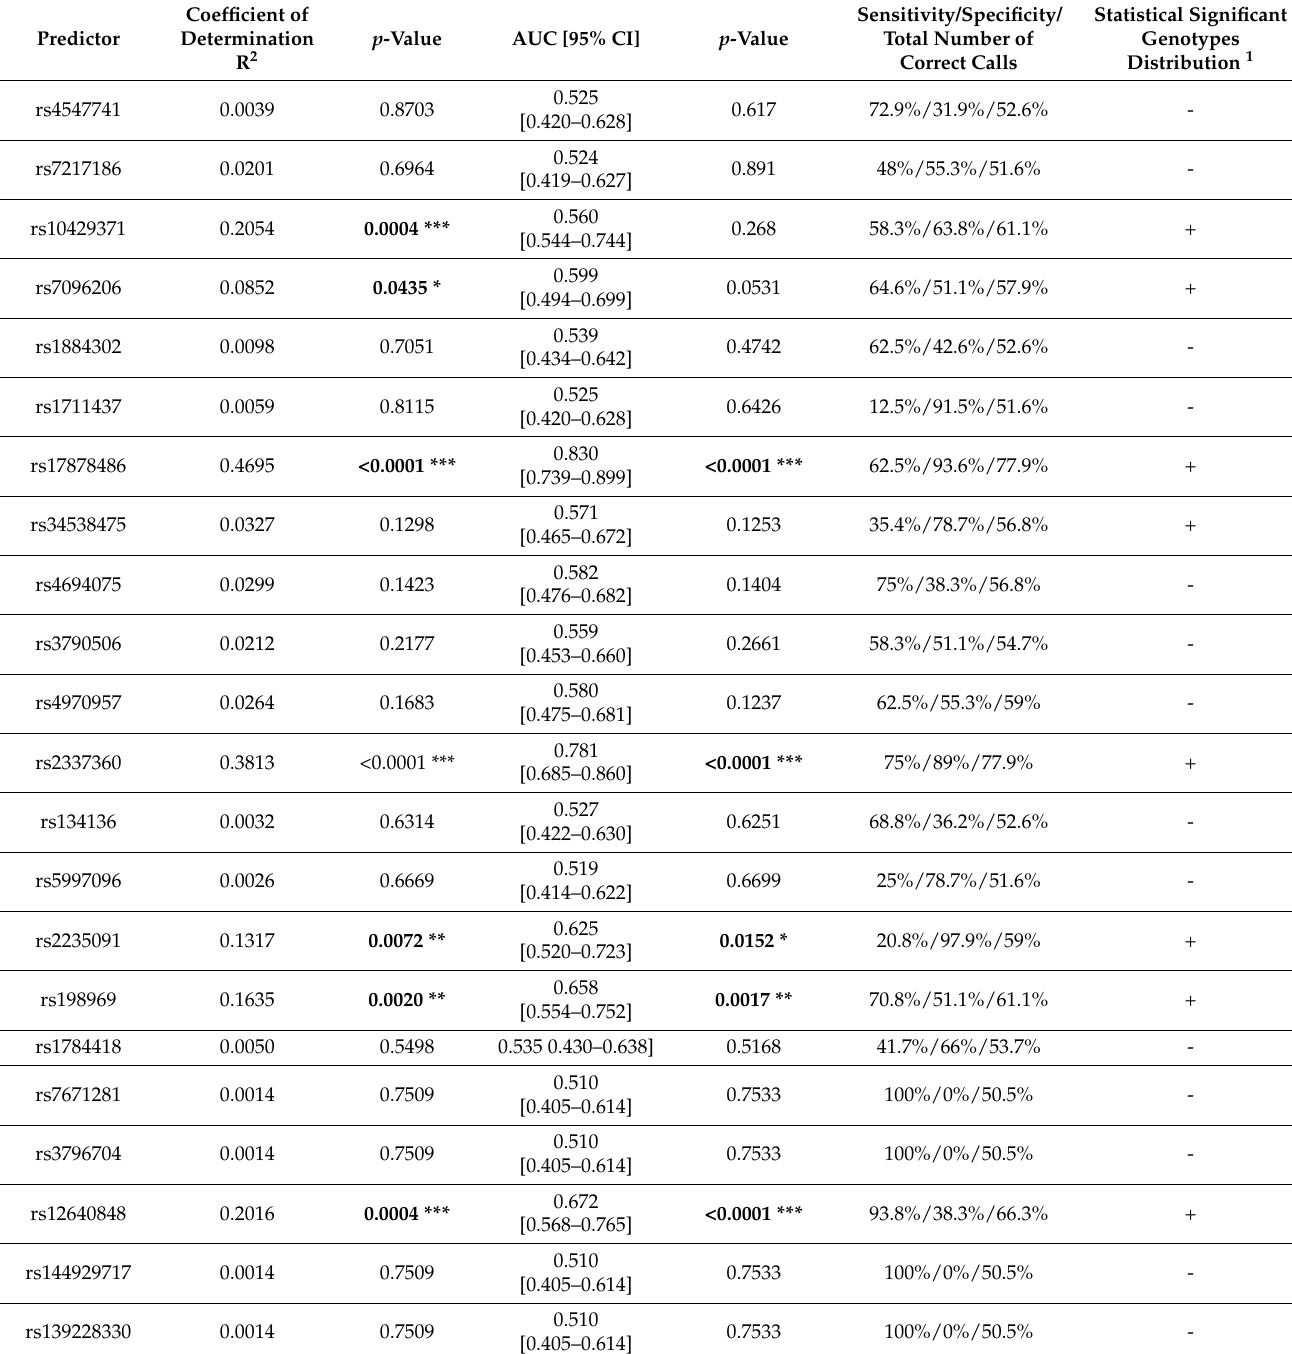
Table 6. The performance of univariable logistic regression